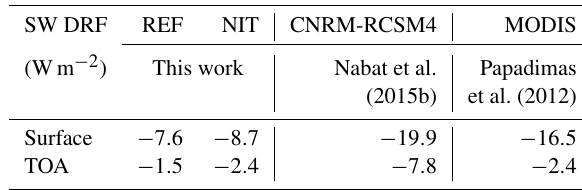
Table 9. Aerosol SW DRF averages (Wm − 2 ) in all sky conditions at the surface and at TOA for different datasets over the